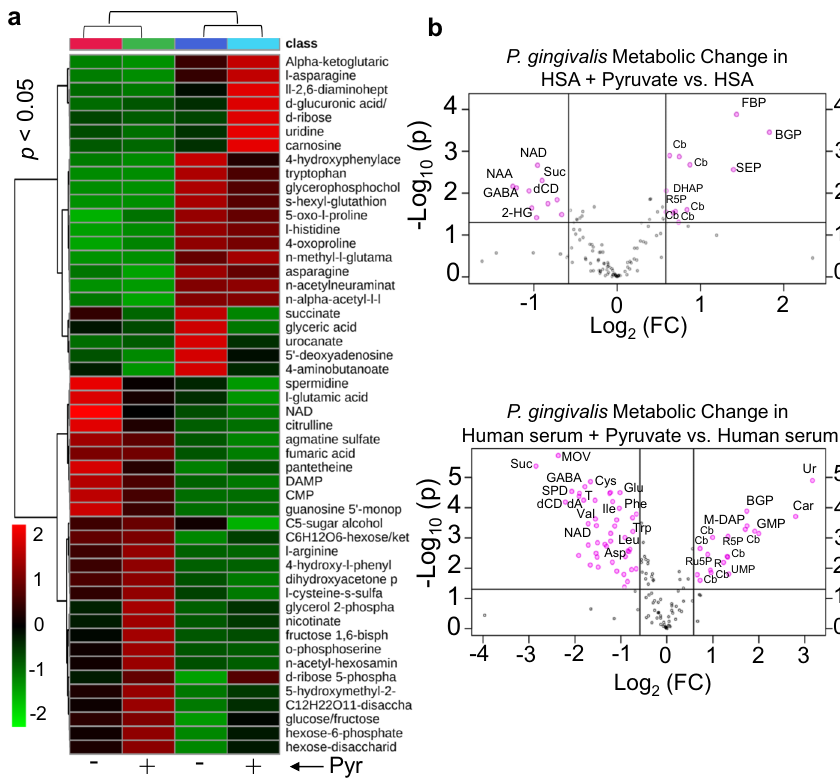
Fig. 5 Statistical analysis of metabolic changes among all groups of P. gingivalis bio fi lm cells grown in HSA or human serum with and without adding pyruvate. a Heatmap represents multigroup analysis for the metabolites of all groups that are found as differentially produced upon one-way ANOVA followed by post hoc analysis ( p value <0.05, n = 3) and variable importance in projection (VIP) values >1.0. b Two-group volcano plot analysis of metabolic changes in HSA or human serum with and without pyruvate. The points in each plot that satisfy the condition p value <0.05 ( t test, n = 3) and fold change ≥ 1.5 appear in pink color, whereas the others that appear in gray are not signi fi cant. OAA oxaloacetate, KG α -ketoglutarate, Lac lactate, PEP phosphoenolpyruvate, ETC electron transport chain, BGP glycerol